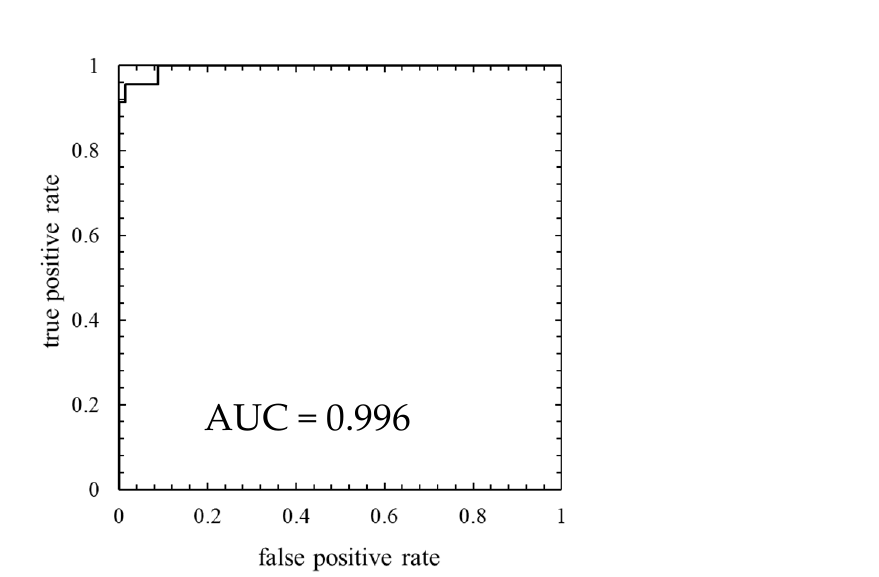
Figure 14. True label and assessment result of the model in which the number of mixture components K was 256 (threshold is 100th percentile’s value): ( a ) wind speed rotational speed characteristic with true label; ( b ) time characteristics of rotational speed with true label; ( c ) wind speed rotational speed characteristic with predicted label; ( d ) time characteristics of rotational speed with predicted label; ( e ) time characteristics of anomaly score.